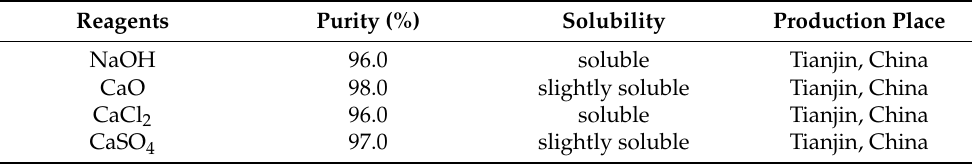
Table 1. Purity of admixture.